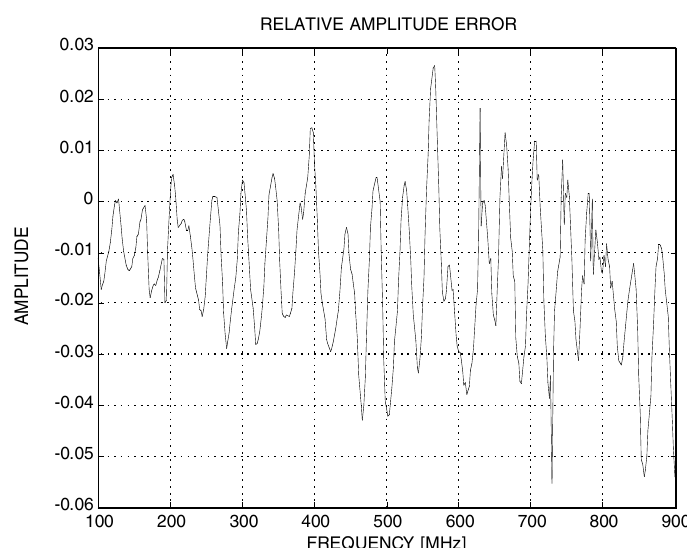
Fig. 10. Relative error (dB) between the nominal and the registered amplitude of a test signal versus frequency.